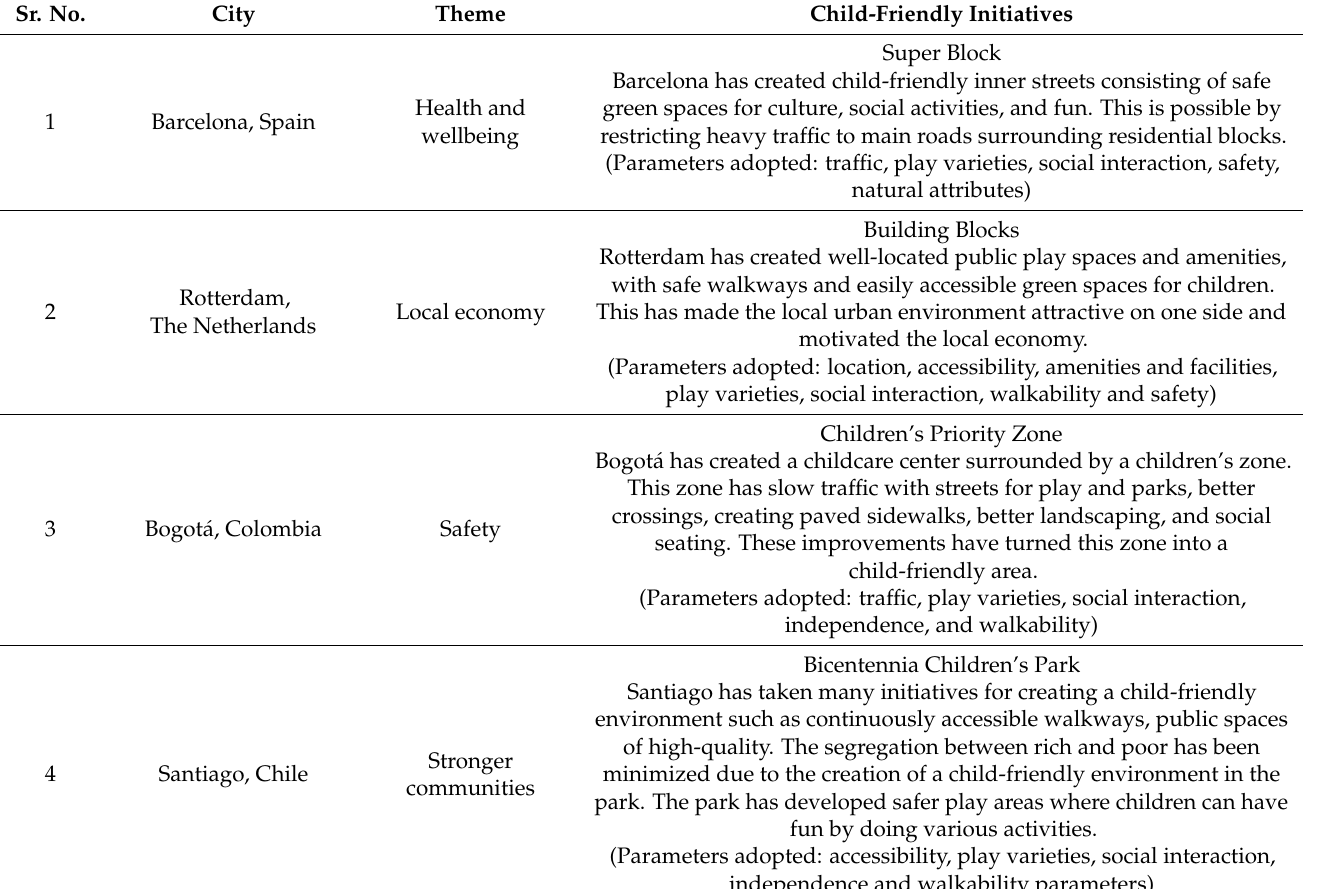
Table 4. International Cases of Child-Friendly